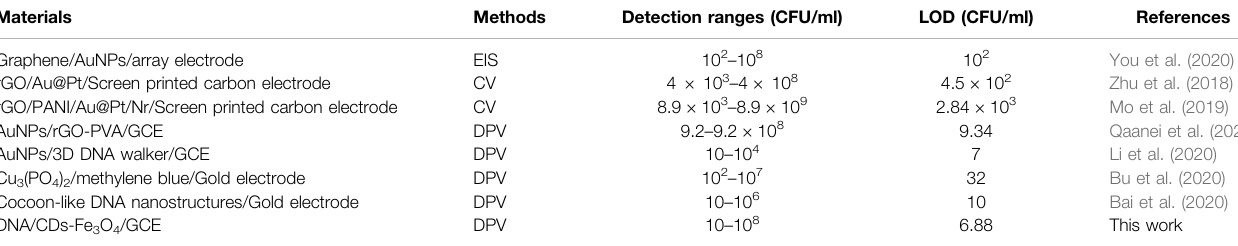
TABLE 1 | Electrochemical biosensors for detecting Escherichia ( E.) coli O157:H7. Materials Methods